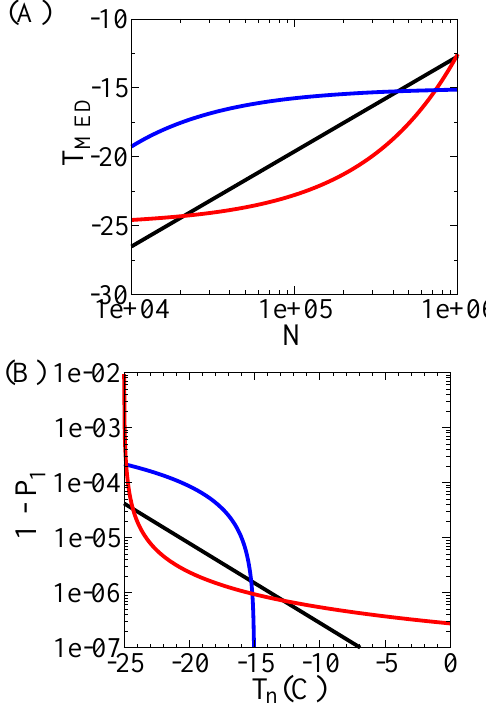
Fig. 1. Plots of: (A) the cumulative distribution function P(T F ) , and (B) the probability density function p(T F ) . T F is the temperature at which a droplet freezes. In both plots the black, red and blue curves are the Gumbel, Fr´echet and Weibull distribution functions, respec- tively. For the Fr´echet distributions ξ = 0 . 75, while for the Weibull distributions ξ = − 0 . 75. For all curves, the location µ =− 20 ◦ C, and the width w = 3 ◦ C. For the P s we use Eq. (9). Note that for the Gumbel distribution, µ and w are related to s , N and w e , by µ = w e ln (sN) and w = w e .